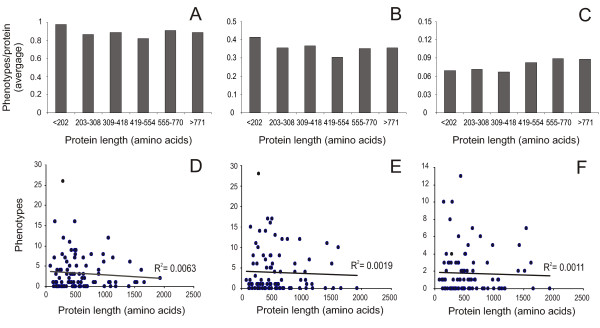
Multi-functionality does not favor large protein size. Comparing quantitative phenotypes of S. cerevisiae deletion strains [27] and protein size A-C) average number of significant (p < 0.001) phenotypes (LPI) in different size categories; data represent all viable deletion strains cultivated in five different conditions (see Material and methods) D-F) number of significant (p < 0.001) phenotypes (LPI) versus protein size for 96 deletion strains cultivated in 36 different conditions (see Material and methods), linear correlation r2 indicated A, D) adaptation time B, E) growth rate C, F) growth efficiency.